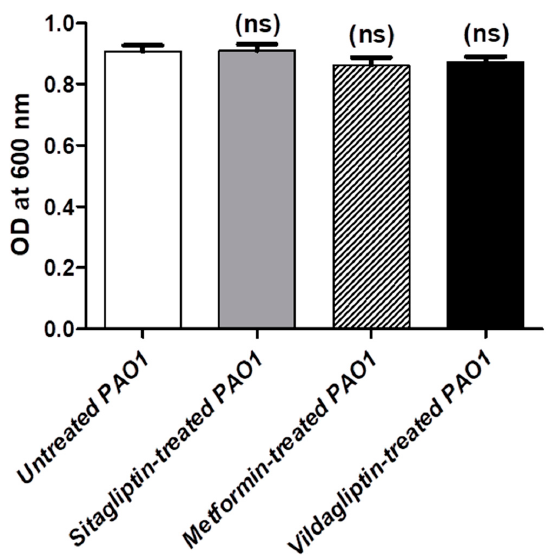
Figure 1. Effect of anti-diabetic drugs in sub-minimum inhibitory concentration (MIC) on growth of P. aeruginosa . The optical densities of P. aeruginosa cultures treated or untreated with